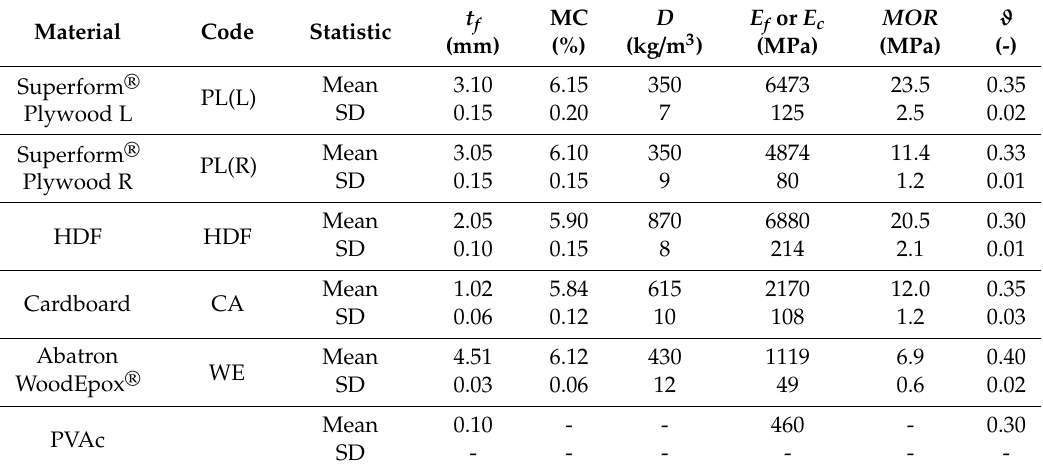
Table 1. Physic-mechanical properties of selected materials